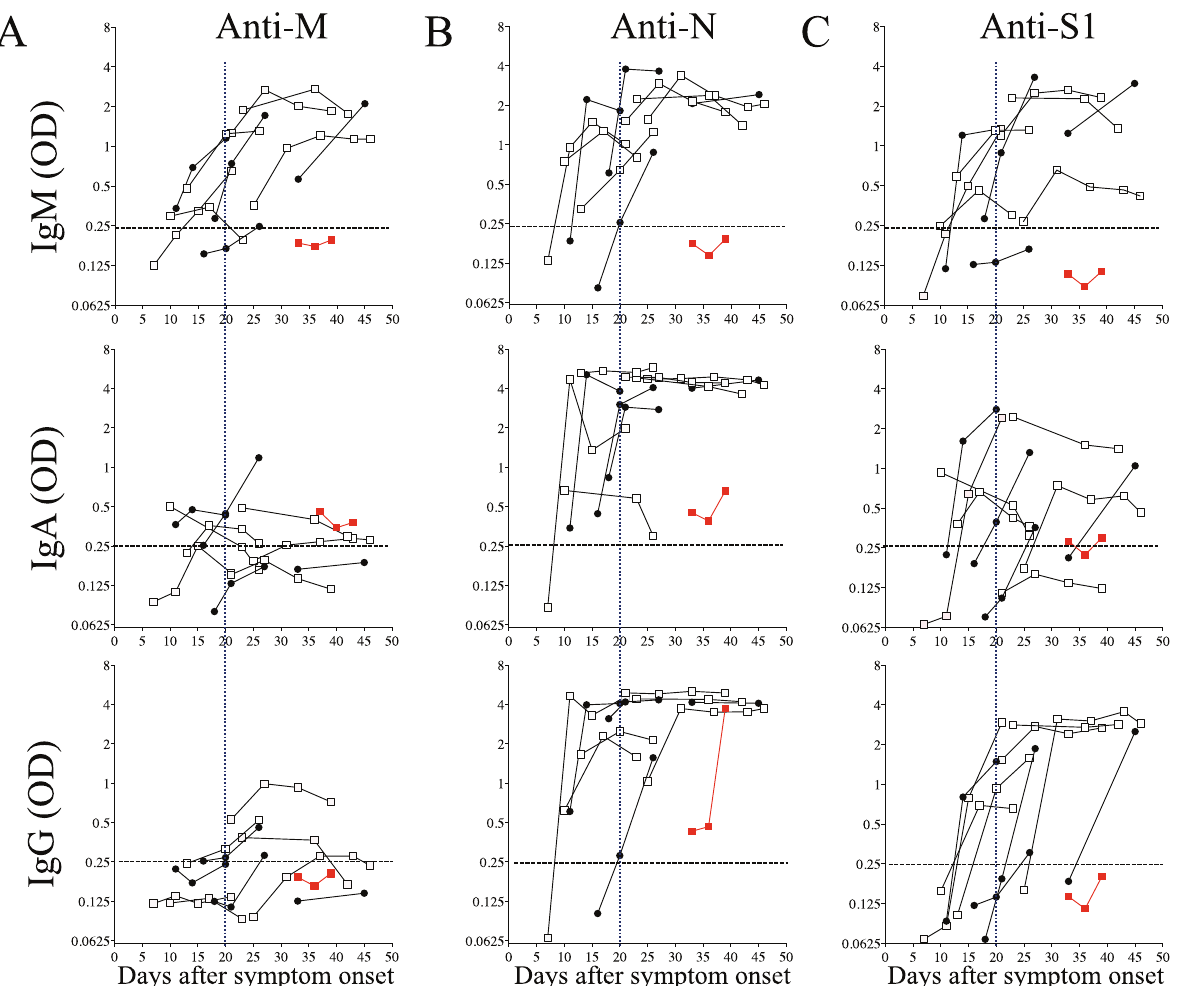
Fig. 4 Humoral response after symptom onset. Plasma after symptom onset was diluted as described in Fig. 1 and tested against A membrane (M), B nucleocapsid (N), and C spike (S1) proteins. Each dot represents an individual. Blank squares and fi lled circles are males and females, respectively. The red dot represents the nonsurviving individual. The horizontal dashed lines represent the antibody speci fi city and the vertical dashed lines represent 20 days from symptom